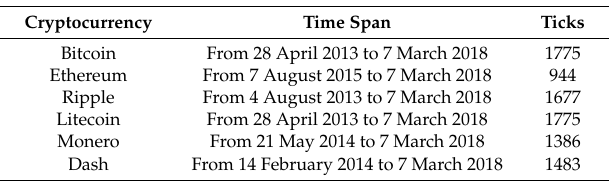
Table 2. Length of the